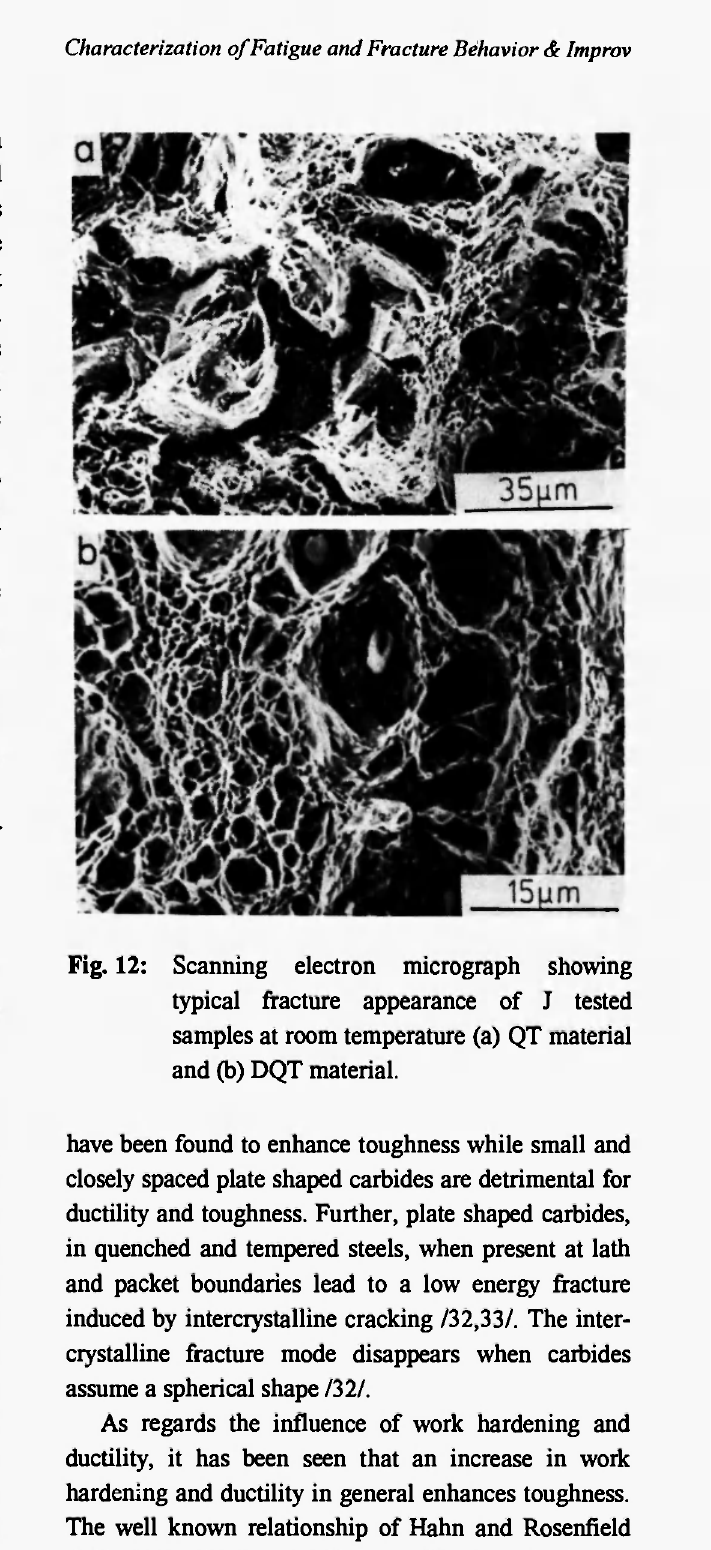
Fig. 12: Scanning electron micrograph showing typical fracture appearance of J tested samples at room temperature (a) QT material and (b) DQT